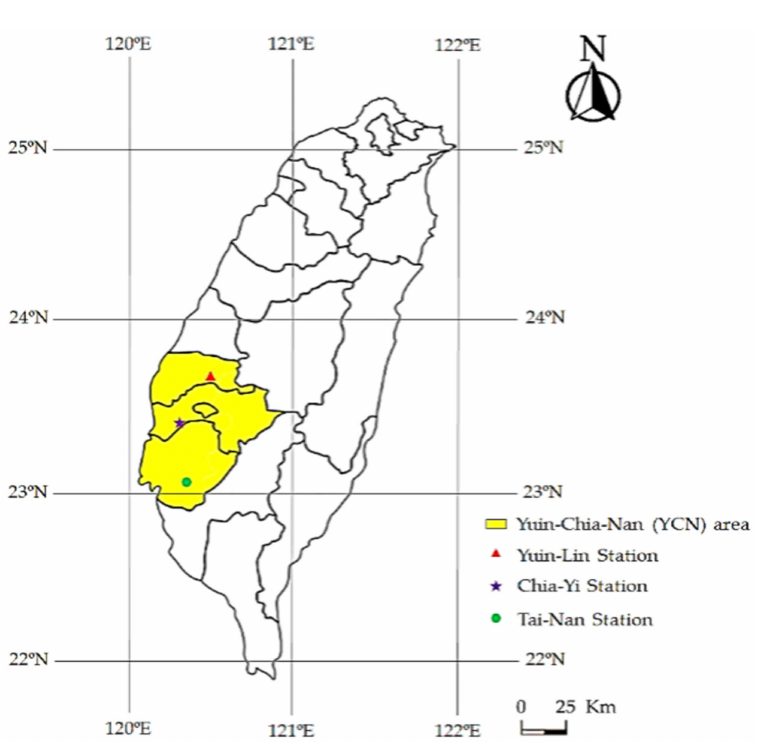
Figure 2. Map showing the location of the Yuin-Chia-Nan (YCN)